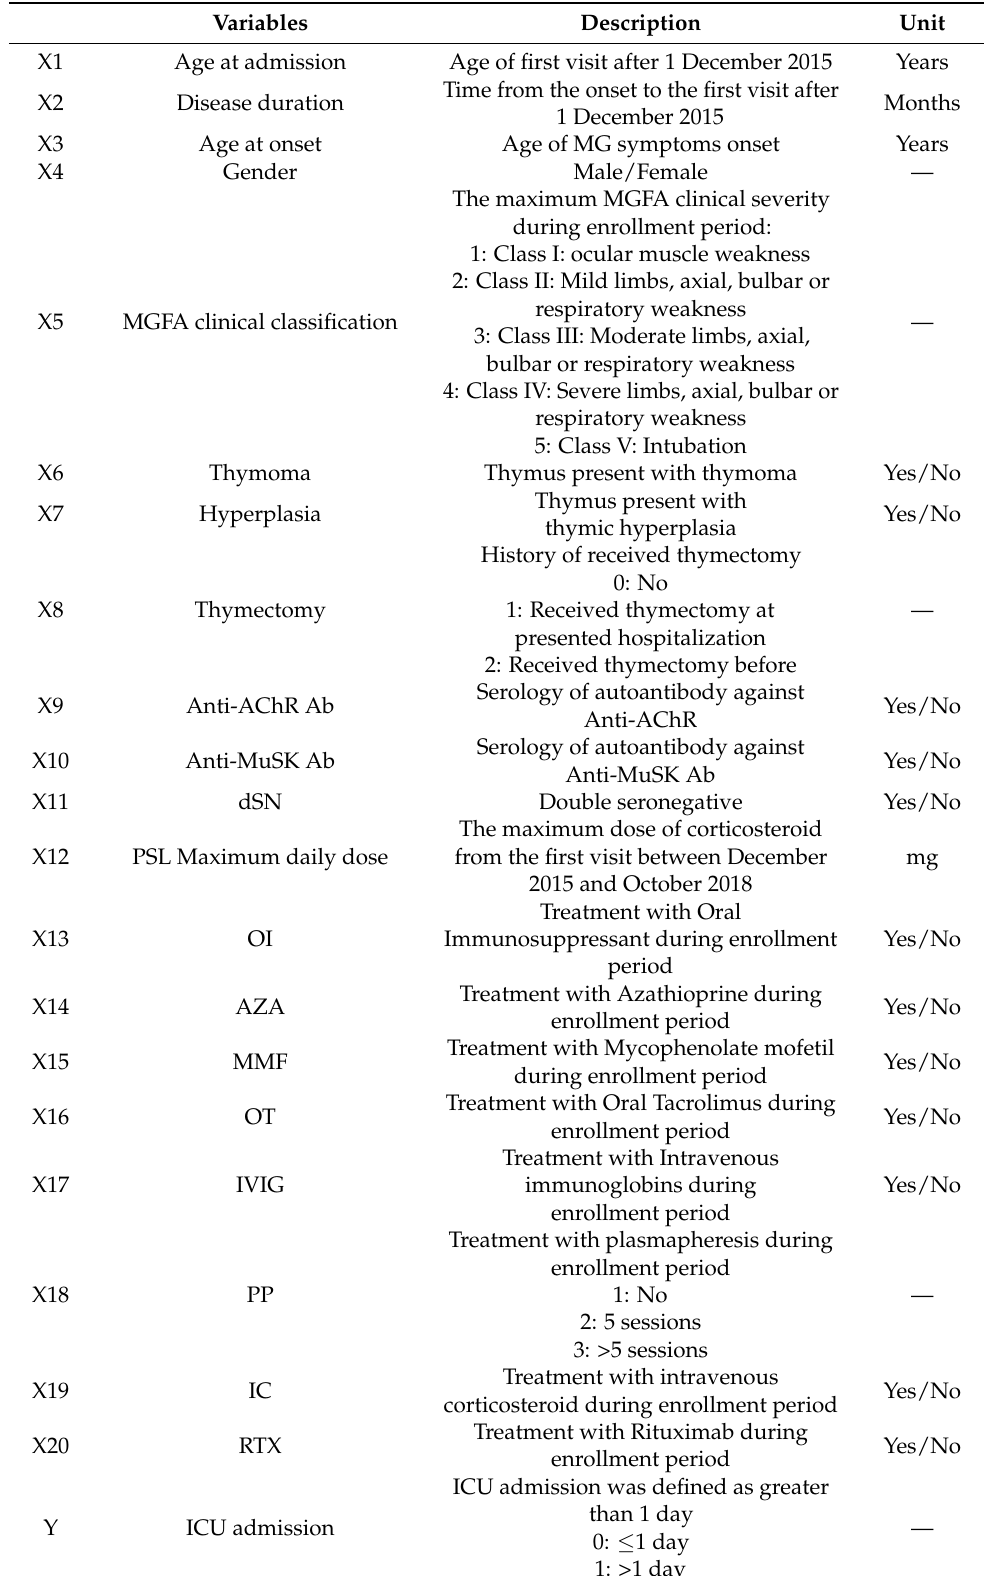
Table 1. Variable